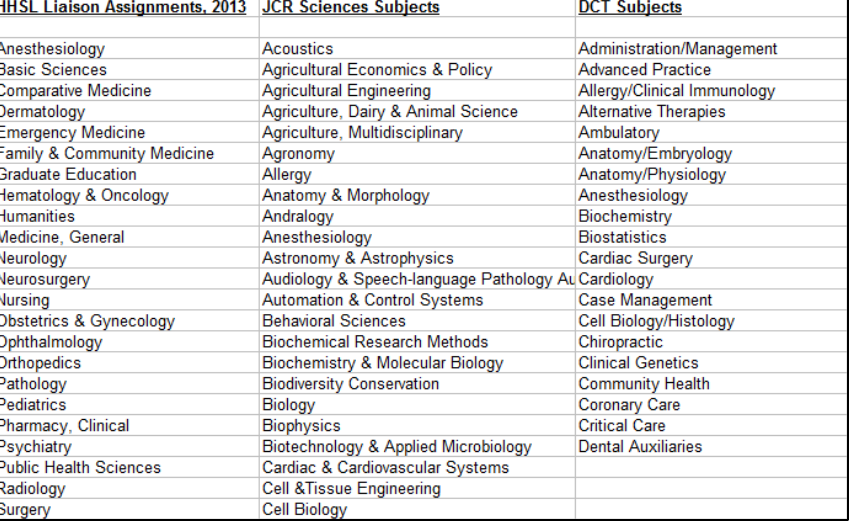
Sample comparison of liaison assignments to JCR and DCT